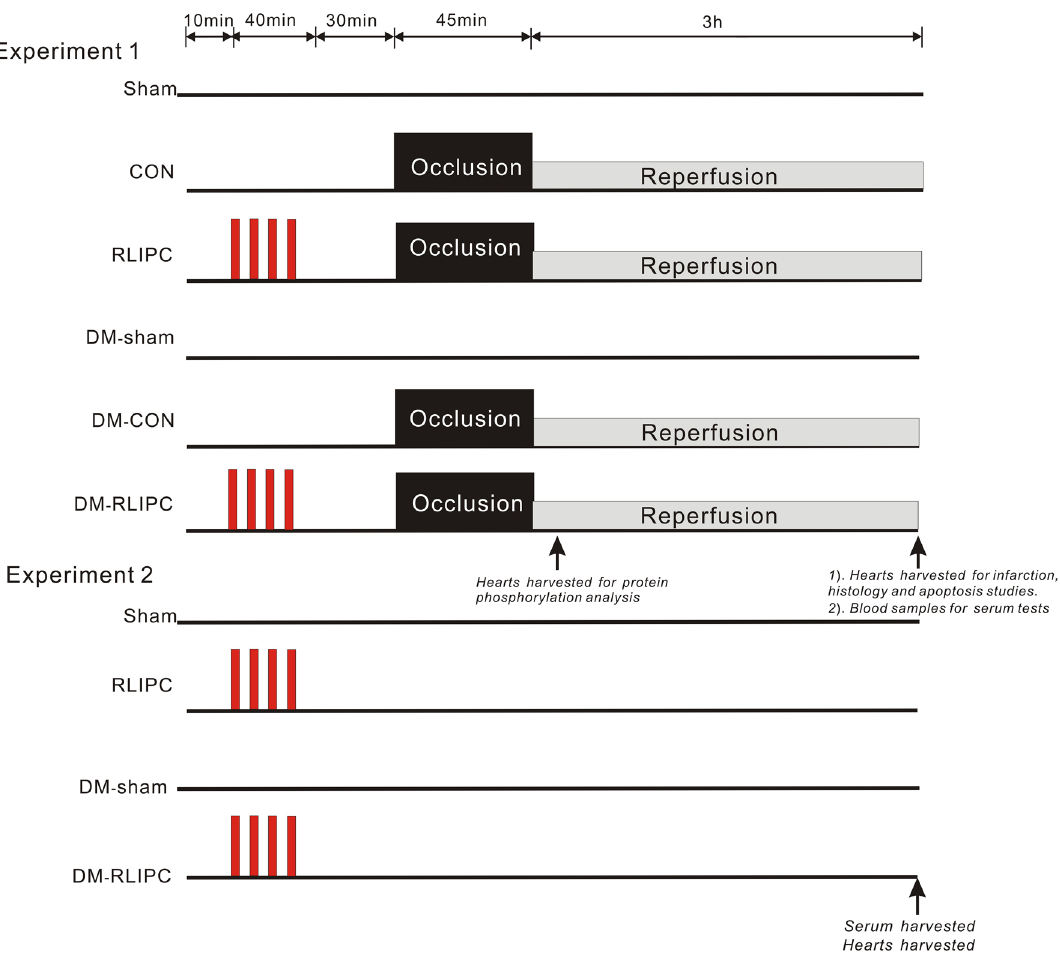
Figure 1. Flowchart of experimental protocol. Red block: four cycles of liver ischemic stimuli. Black block: duration of left anterior descending (LAD) coronary occlusion. Grey block : duration of reperfusion. Sham: sham-operated surgery, CON: LAD occlusion only, RLIPC: remote liver ischemic preconditioning , DM: STZ- induced diabetes